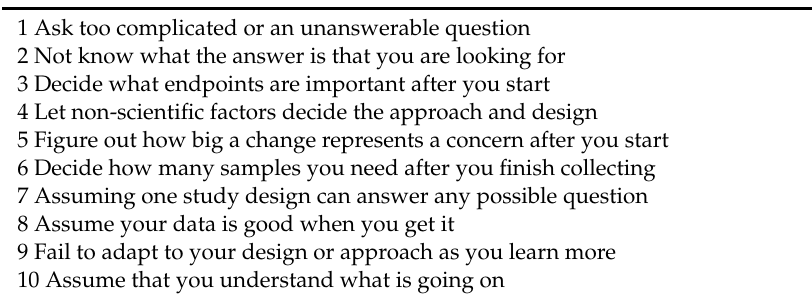
Table 3. Common problems with monitoring programs that represent the major failures in programs, in order of